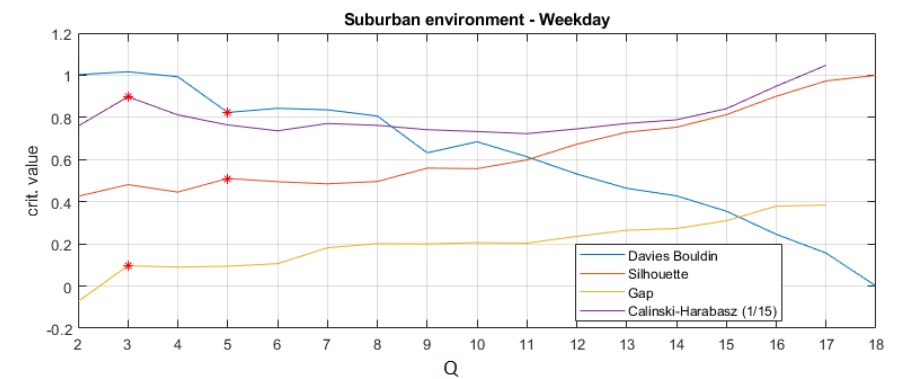
Figure 5. Clustering validity indices obtained for the acoustic suburban environment on the weekday, resulting from the agglomerative hierarchical clustering algorithm for the considered number of clusters sweep 2 ≤ Q ≤ 18. The suboptimal number of clusters are marked as red asterisks, being the local maxima in all clustering indices despite the Davies–Bouldin index, which is a local